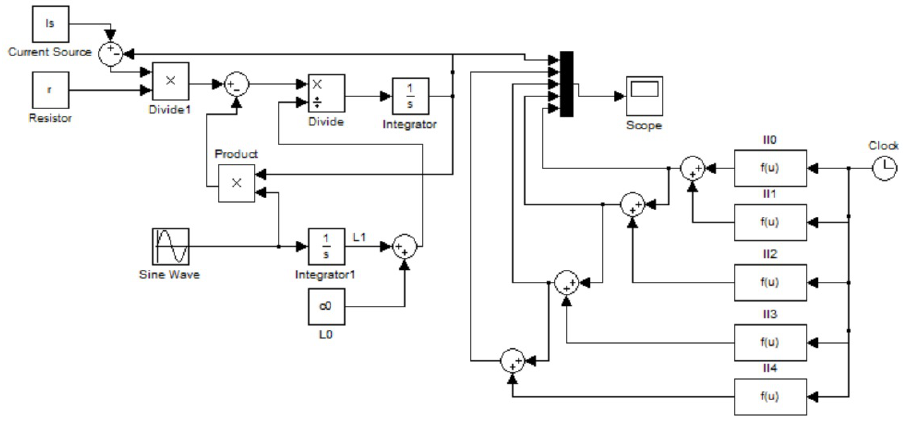
Figure 2. The Simulink block diagram for the